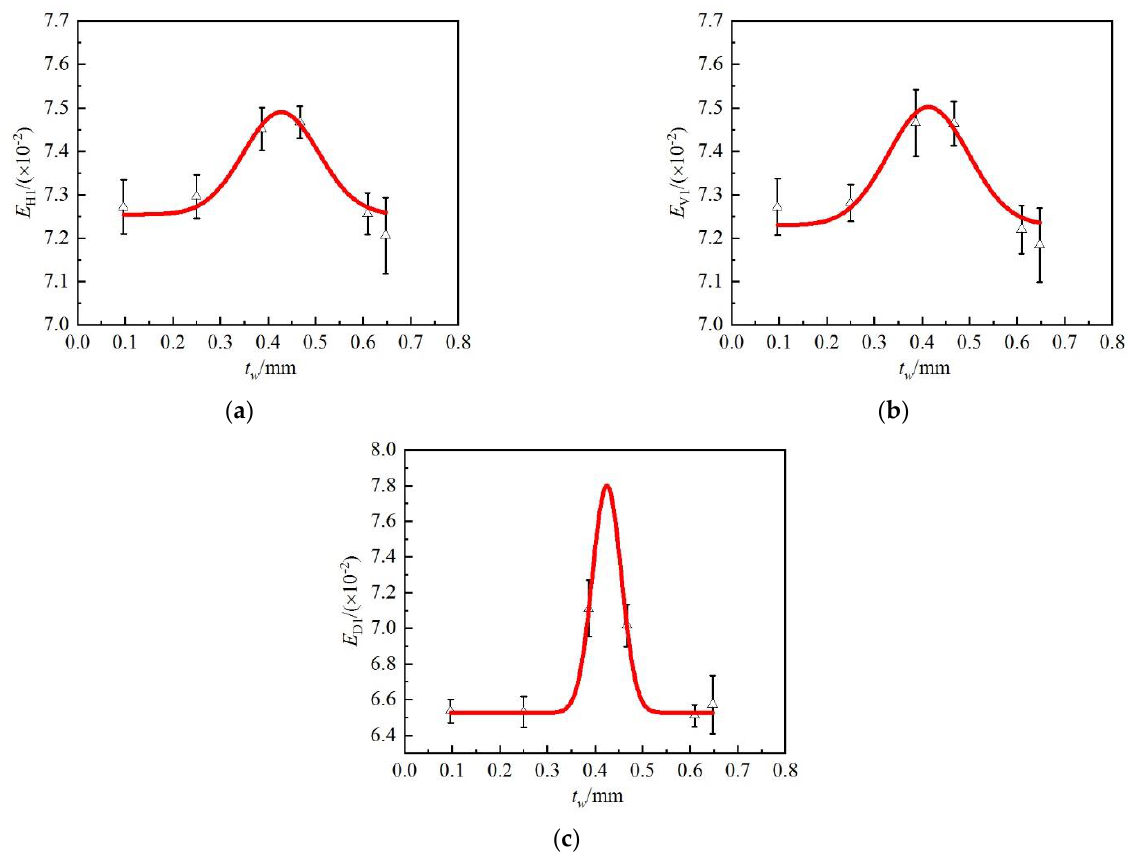
Figure 5. Relationship between energy values of the sub-images obtained after one-level wavelet transform and the corrosion depths: ( a ) E H1 - t w , ( b ) E V1 - t w , ( c ) E D1 - t w . Table 4. Fitting equation and significance test of the relationship between image features after rust removal (sub-image energy value, information entropy value) and corrosion depth.